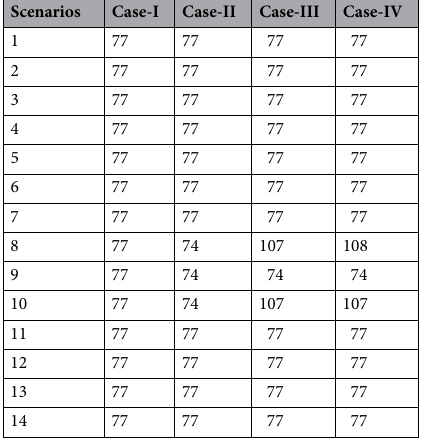
Table 6. Numerical data of BCs for the fluid